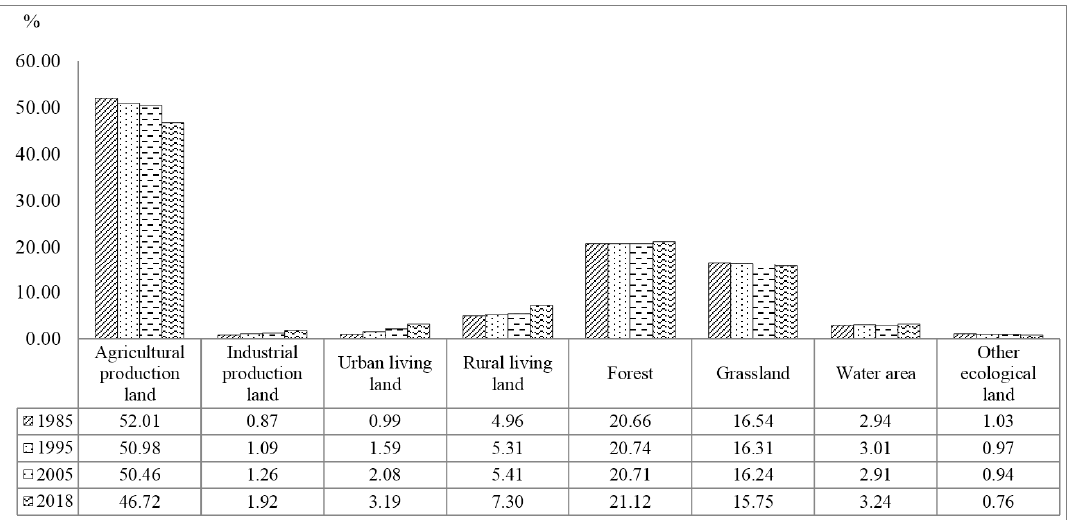
Figure 4. Change of the land use structure from 1985 to 2018.